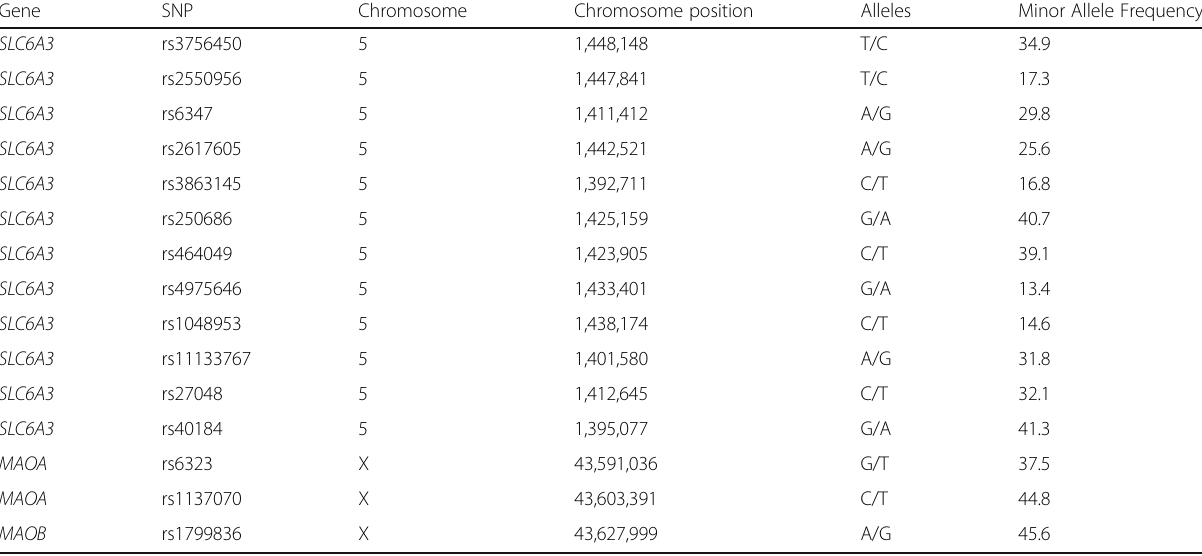
Table 3 List of analyzed polymorphic variants of the dopamine transporter gene and the monoamine oxidase genes Gene SNP Chromosome